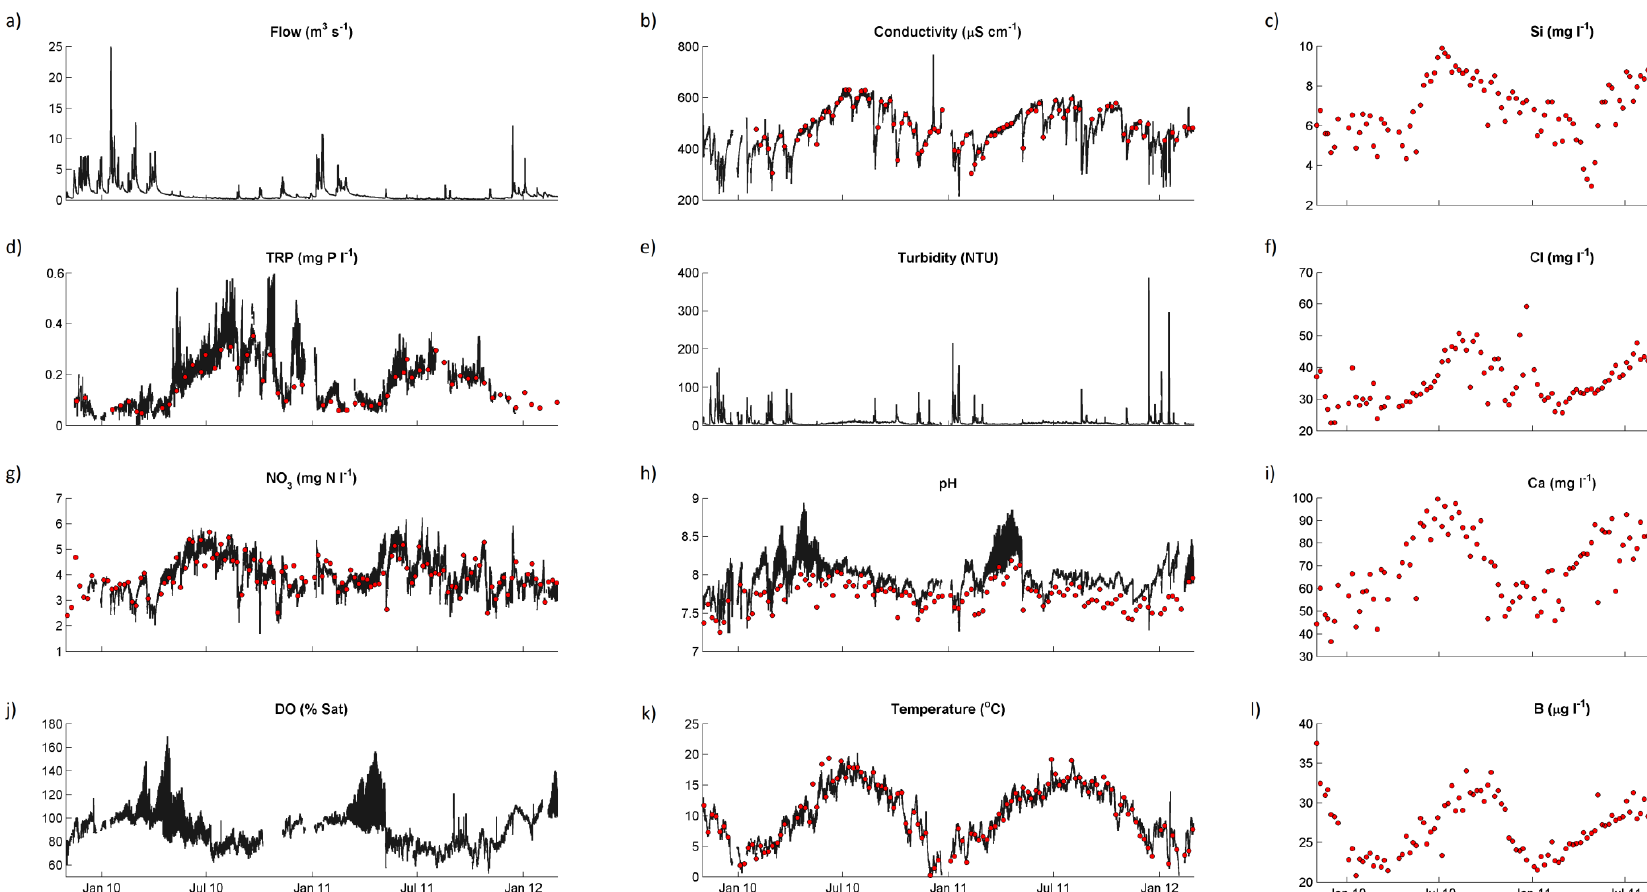
Figure 4. Concentrations of selected chemical determinands in the River Enborne at Brimpton during the study period: black lines, hourly data; red points, weekly data. ( a ) Flow; ( b ) Conductivity; ( c ) Silicon; ( d ) Total reactive phosphorus; ( e ) Turbidity; ( f ) Chloride; ( g ) Nitrate; ( h ) pH; ( i ) Calcium; ( j ) Dissolved oxygen; ( k ) Temperature; and ( l )